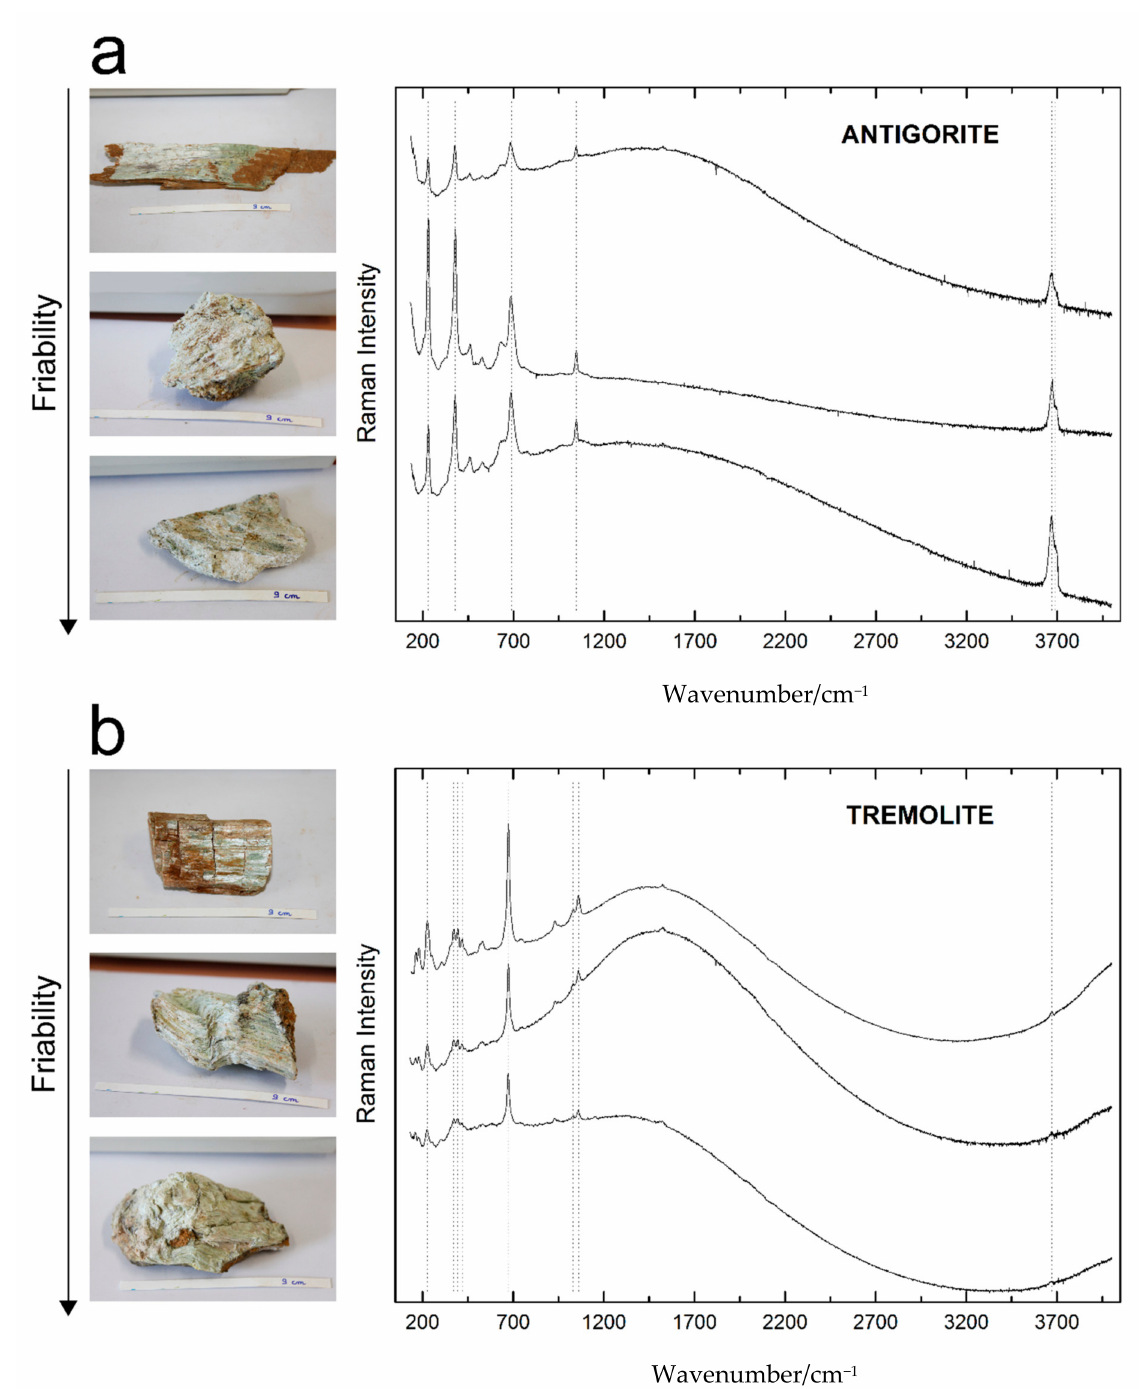
Figure 3. Estimation of performance of portable Raman on differently cohesive, from massive to friable-powdered, asbestos- bearing veins from Tontouta Ni- open pit mine. ( a ) antigorite; ( b ) tremolite. Raman spectra were acquired in the extended spectral region (100–4000 cm − 1